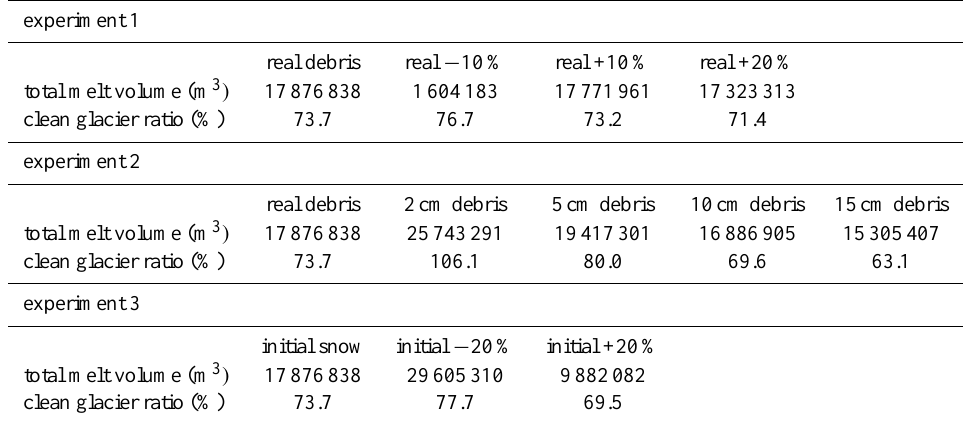
Table 4. Results from sensitivity experiments of the ablation model for the Zopkhito basin. The experiments are identical to the ones in Table